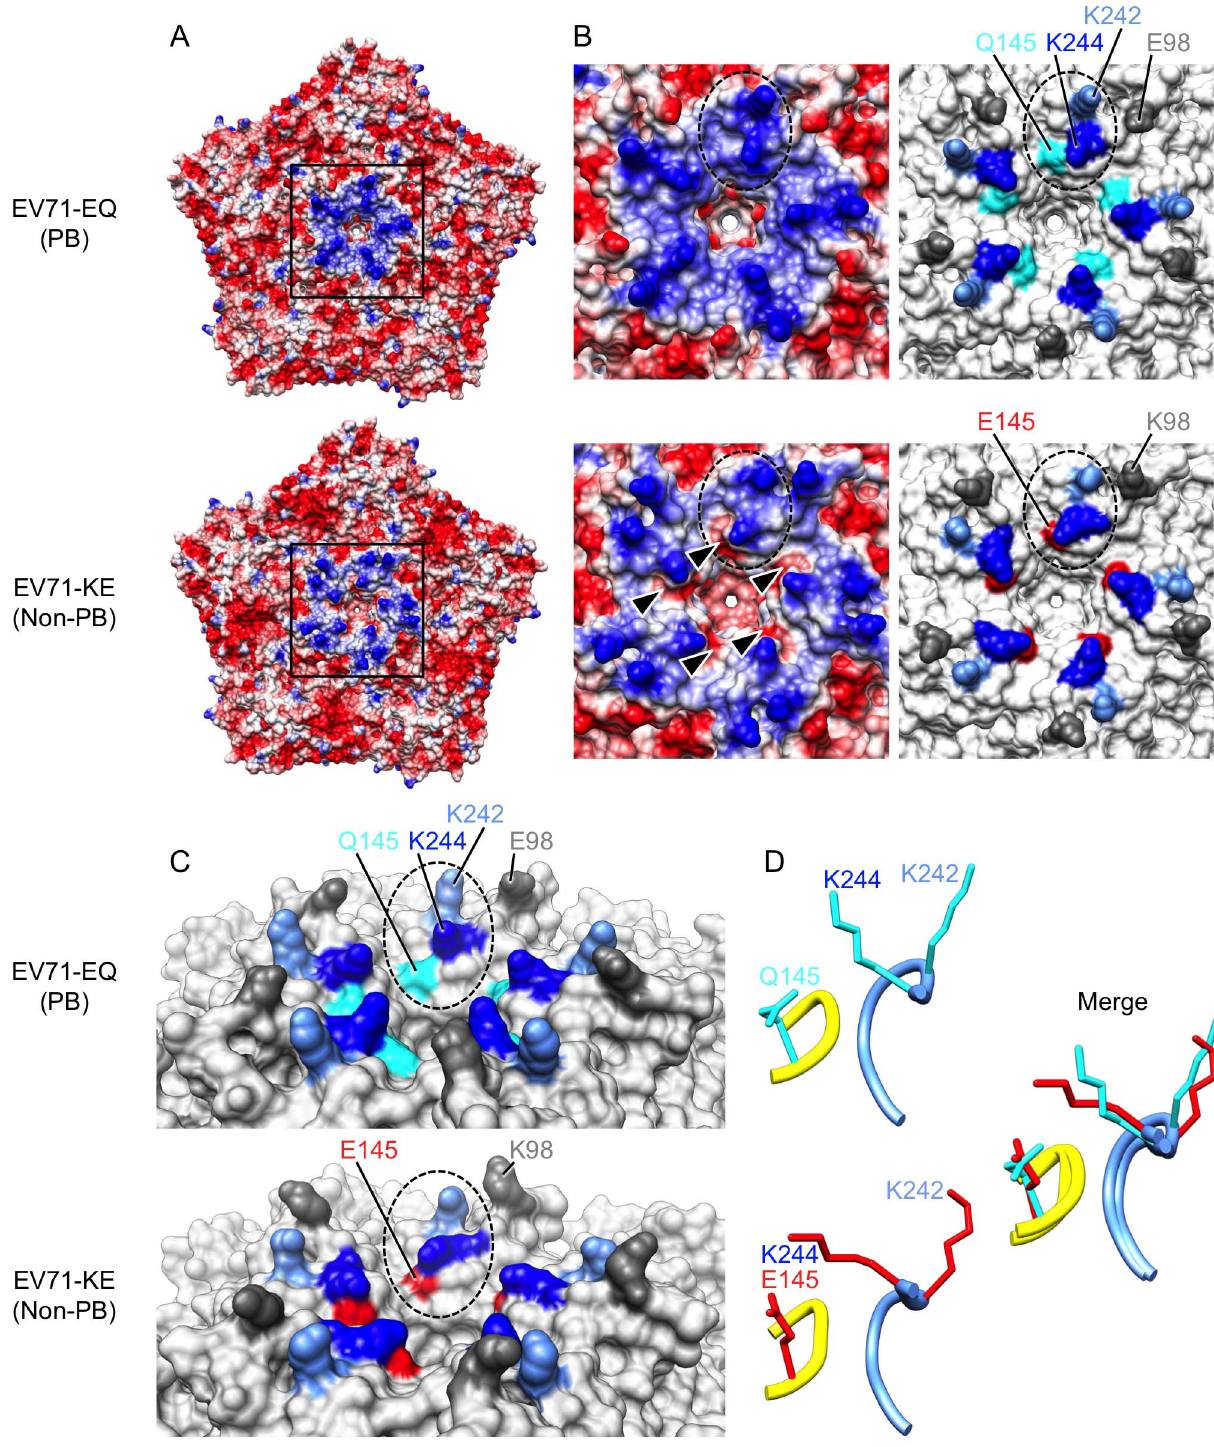
Figure 3. Comparison of EV71-PB and EV71-non-PB structures. Molecular surfaces of EV71-EQ (4AED; presumably PB, top of each figure section) and EV71-KE (3VBS; presumably non-PB, bottom of each figure section). (A) Electrostatic surface coloring of five icosahedral asymmetric units using UCSF Chimera software with ‘coulombic surface coloring’ function. Negatively charged surfaces are shown in red, whereas positively charged areas are shown in blue. Black-boxed areas are enlarged and shown in (B). (B) Molecular surfaces around the five-fold axis of symmetry. Dotted ovals indicate a set of VP1-145, VP1-242, and VP1-244. Left panels show electrostatic surface coloring. Arrowheads in EV71-KE show negatively charged patches around VP1-145E. Right panels show the positions of specific residues (dim gray, VP1-98; cyan, VP1-145Q; red, VP1-145E; cornflower blue, VP1-242K; blue, VP1-244K). (C) Oblique views of the five-fold axis. Dotted ovals indicate a set of VP1-145, VP1-242, and VP1-244. Specific residues are colored as in (B). (D) Loop structures of partial VP1-DE (yellow, VP1-142 to -145) and partial VP1-HI loops (cornflower blue, VP1-238 to -244) depicted in ribbon form. Side chains for the residues VP1-145, VP1-242, and VP1-244 are displayed as sticks (cyan, EV71-EQ; red, EV71-KE). doi:10.1371/journal.ppat.1003511.g003 PLOS Pathogens |